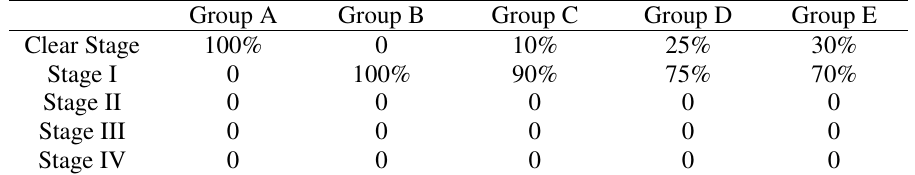
Table 1. Effect of Triphala ghrita on the onset of galactose-induced cataract in rats observed after 7 days